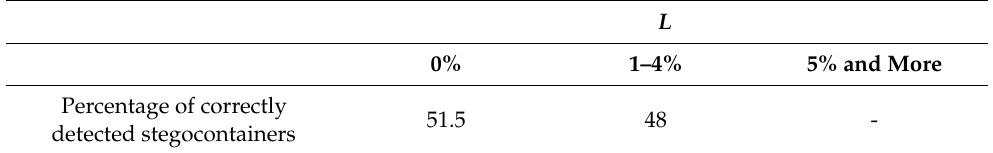
Table 4. RS analysis on a set of 225 × 225 containers filled using the interpolation method by